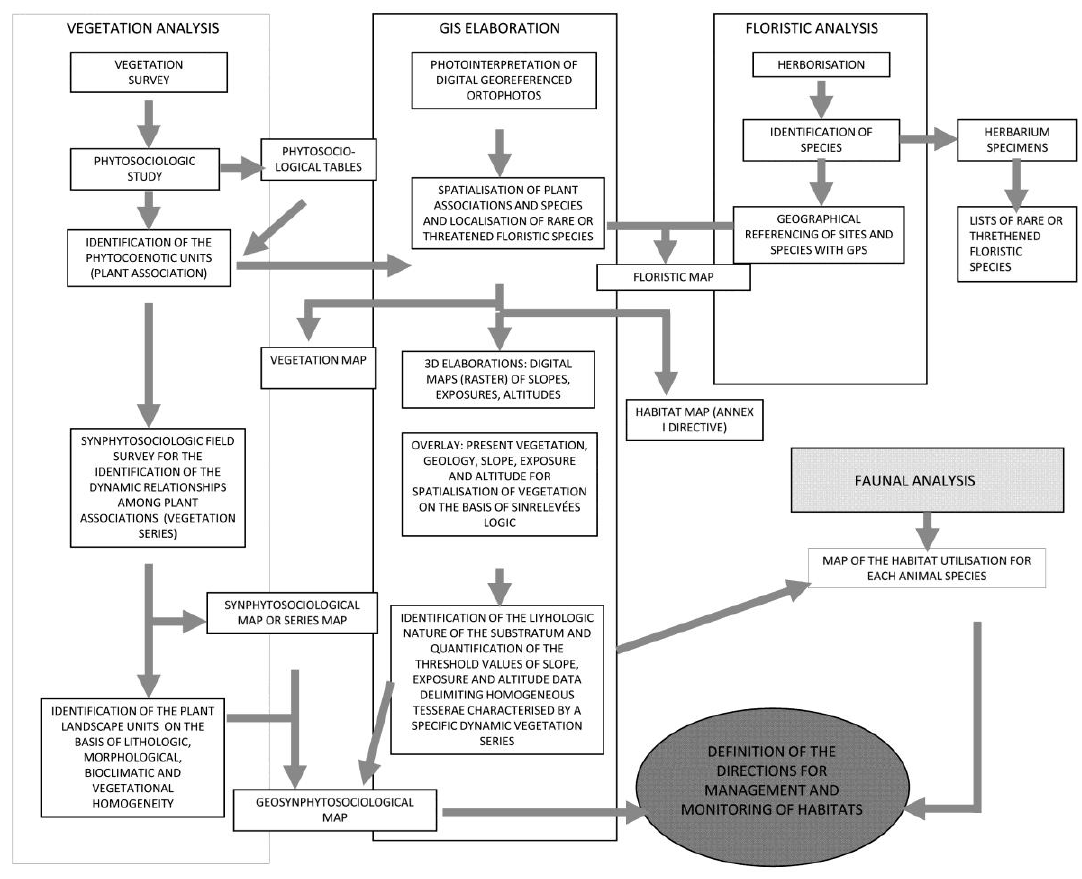
Figure 3. The methodological scheme for integrated analysis of the plant